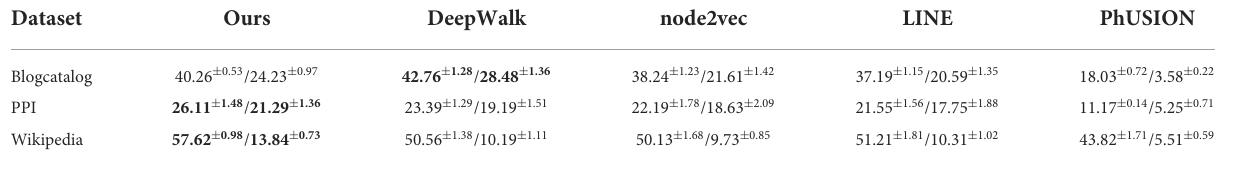
TABLE 2 Average micro-f1/macro-f1 scores for multi-label classification task.